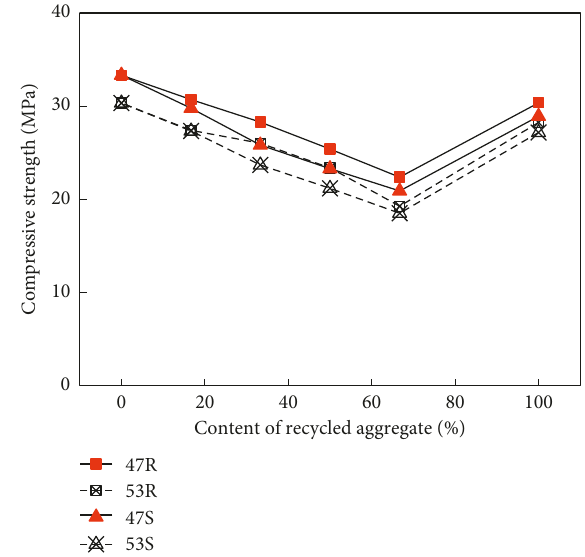
Figure 4: Relationship between compressive strength and content of recycled